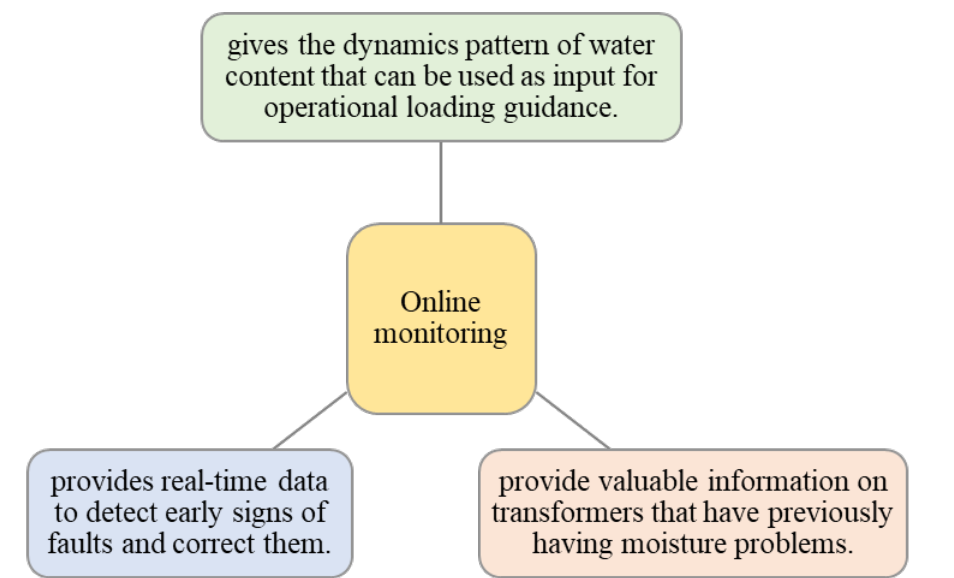
Figure 5. The advantages of online monitoring based on the saturation meter method [42].